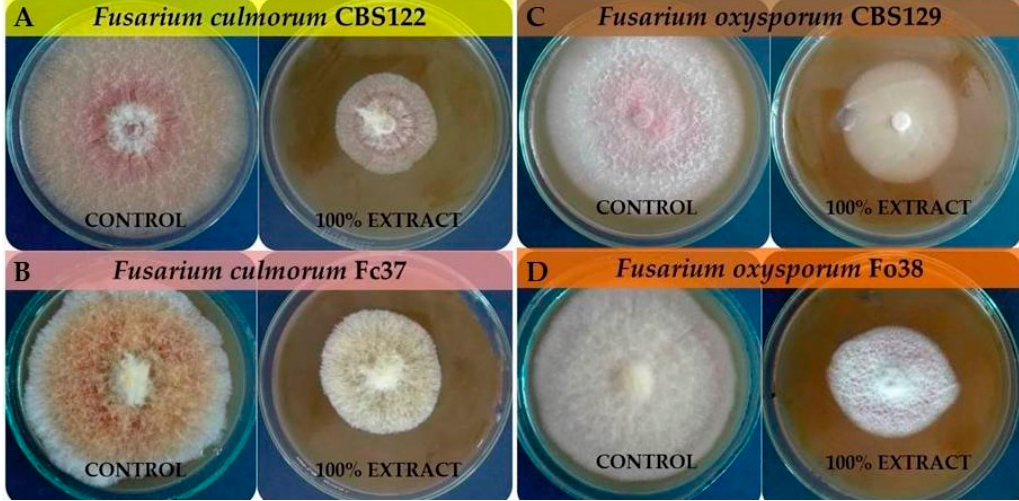
Figure 3. The effect of 100% F. vesiculosus extract on F. culmorum (CBS122 ( A ), Fc37 ( B )) and F. oxysporum (CBS129 ( C ), Fo38 ( D )) on PDA medium after 168 h of incubation.